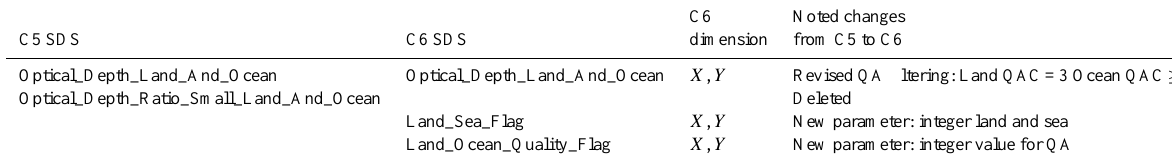
Table 5. C6 joint land and ocean data products that are changed from C5.